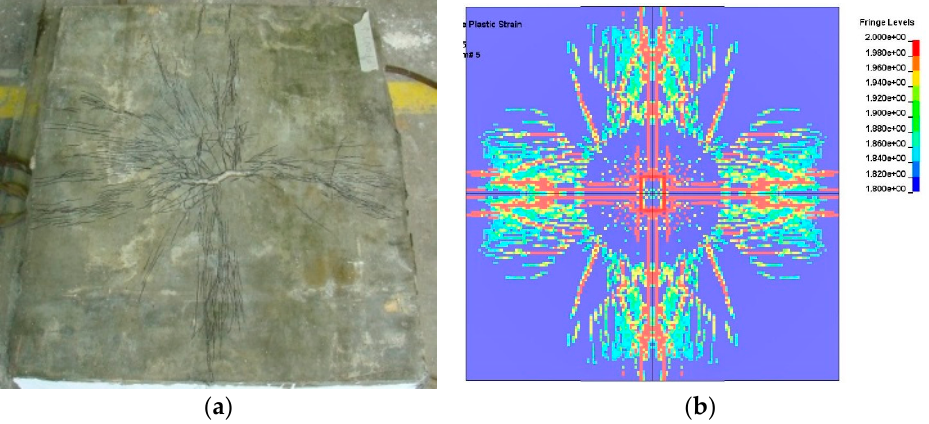
Figure 19. ECC bottom after the second impact: ( a ) damage pattern of the bottom of ECC layer in the laboratory test; ( b ) damage pattern of the bottom of ECC layer in the numerical simulation. Table 12. Summary of the settlements of the multi ‐ layer slab from both numerical and experiment results.